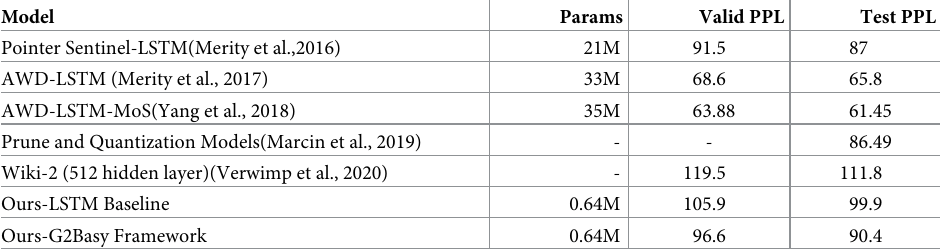
Table 10. Word-level valid and test perplexity on WikiText-2.